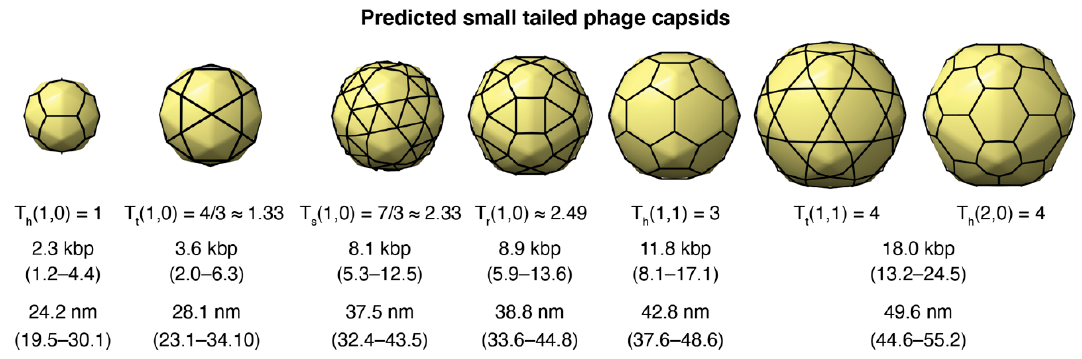
Figure 4. Predicted small-tailed phage capsids. The sequence of three-dimensional (3D) capsid icosahedral models generated with the new hkcage tool in ChimeraX and available in https://github.com/luquelab/hkcage.git. The information below each structure corresponds to the T-number architecture, (h,k) steps, lattice (h: hexagonal, t: trihexagonal, s: snub hexagonal, and r: rhombitrihexagonal), the average predicted genome length (95% confidence interval), and the average predicted capsid diameter (95% confidence interval).